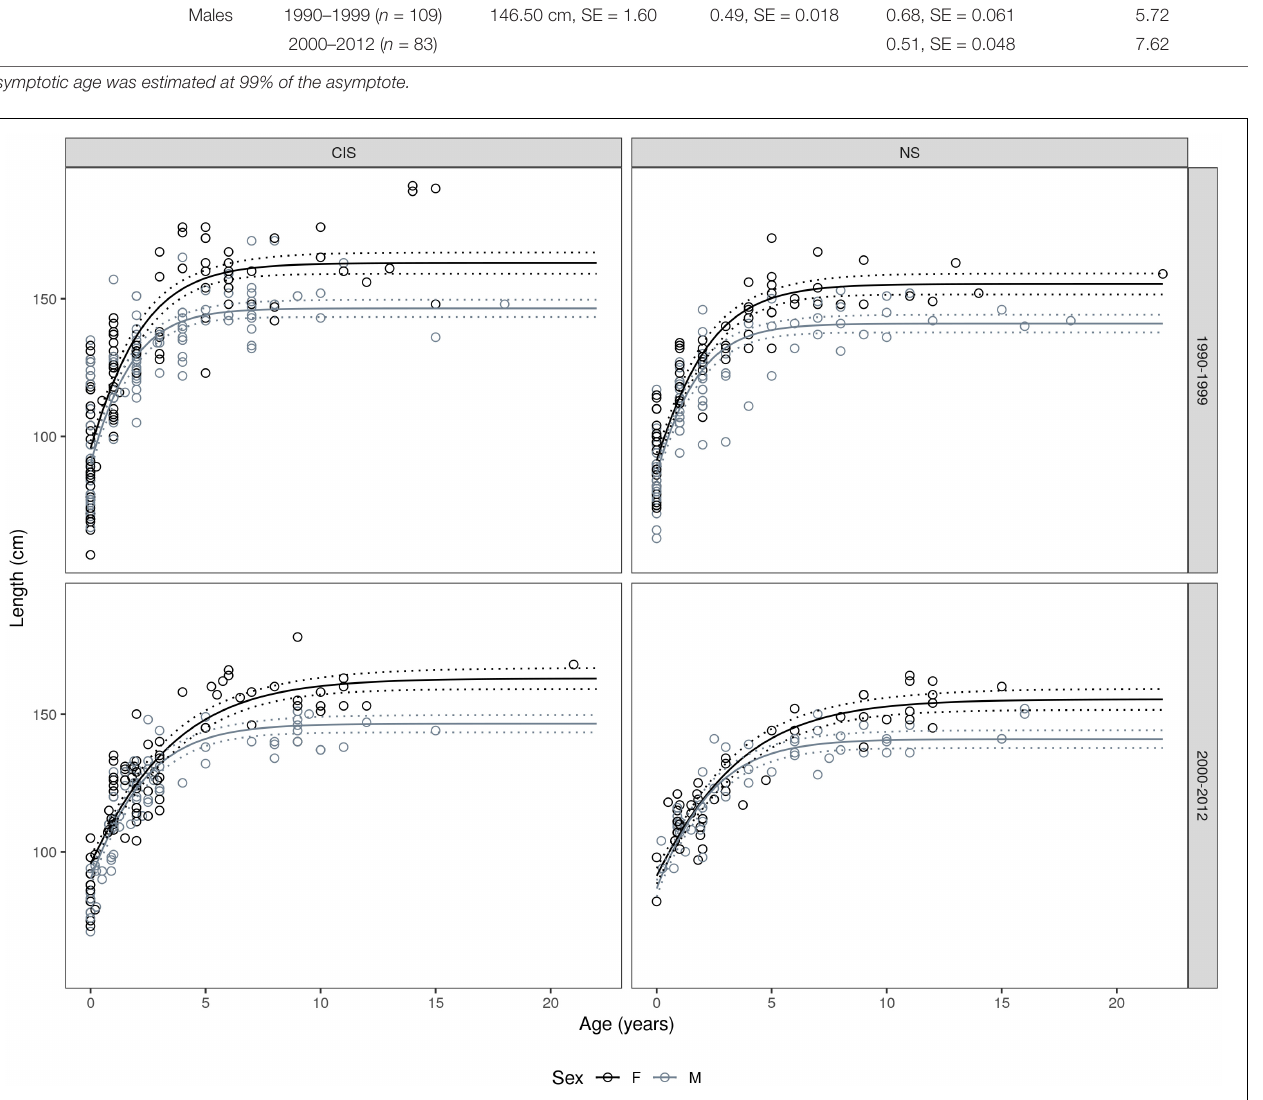
from the Celtic and Irish Seas MU, and female porpoises in the North Sea